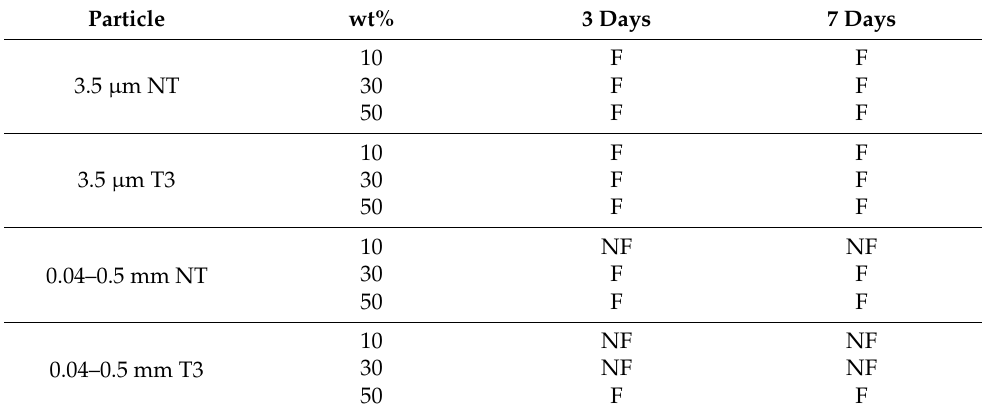
Table 2. Results obtained by SEM for biocomposites with different BG particle size, content, thermal treatment and immersion time in SBF. With F, formation and NF, non-formation of HA layer. Particle wt% 3 Days 7 Days 10 F F 30 F F 3.5 µ m NT 50 F F 10 F F 30 F F 3.5 µ m T3 50 F F 10 NF NF 30 F F 0.04–0.5 mm NT 50 F F 10 NF NF 30 NF NF 0.04–0.5 mm T3 50 F